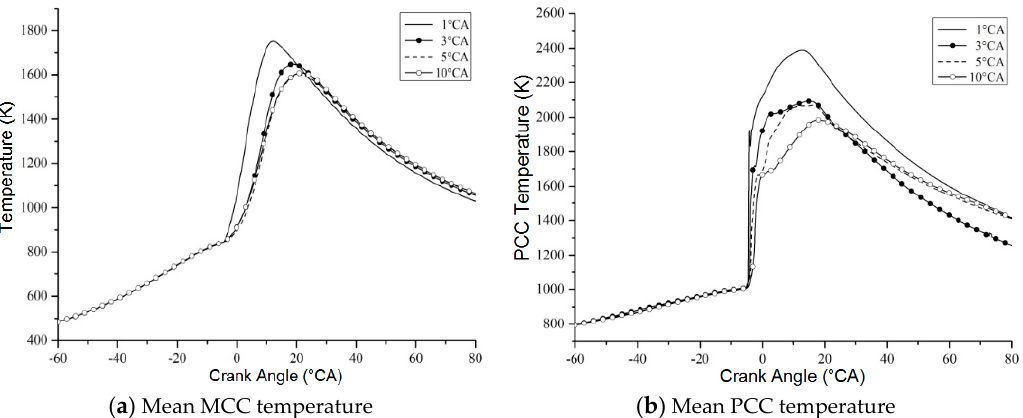
Figure 21. Mean temperature under different pilot injection durations.